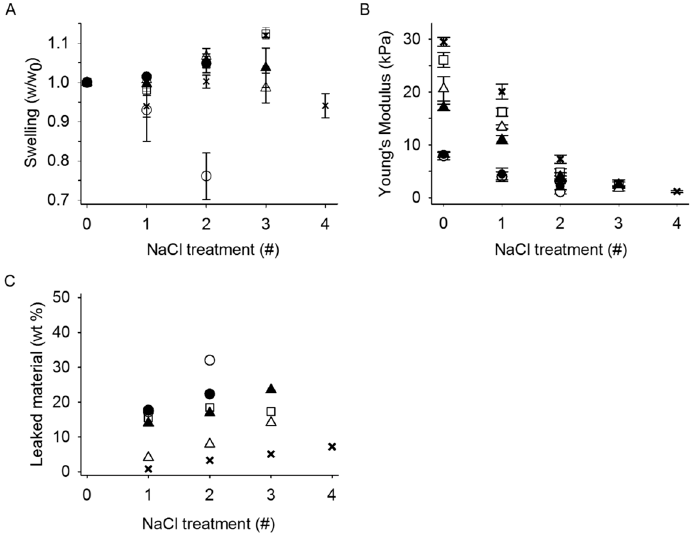
Figure 6. Stability of 1.0% w / v alginate / POA (P 0 = 0.08) and alginate / POA-MeOTyr (P 0 = 0.08, DS = 7.0%) mixed hydrogels ( n = 5) after consecutive NaCl treatments. One NaCl treatment: immersing the gels in 0.15 M NaCl for 24 h. ( A ): Young’s modulus (E), ( B ): Swelling ( w / w 0 ) and ( C ): leaked material (wt%) relative to theoretical total mass of alginate in the gels. Data points at zero saline treatment represents the initial values before immersing the gels in the first saline bath. x: L. hyperborea stipe alginate, □ : alginate/POA W POA = 0.25, ∆ : alginate/POA W POA = 0.50 ○ : alginate/POA W POA = 0.75, ▲ : alginate/POA- MeOTyr W POA–MeOTyr = 0.50 ● : alginate/POA-MeOTyr W POA–MeOTyr = 0.75. Abbreviations: POA = partially oxidized alginate. POA-MeOTyr = POA grafted with L -Tyrosine methyl ester.